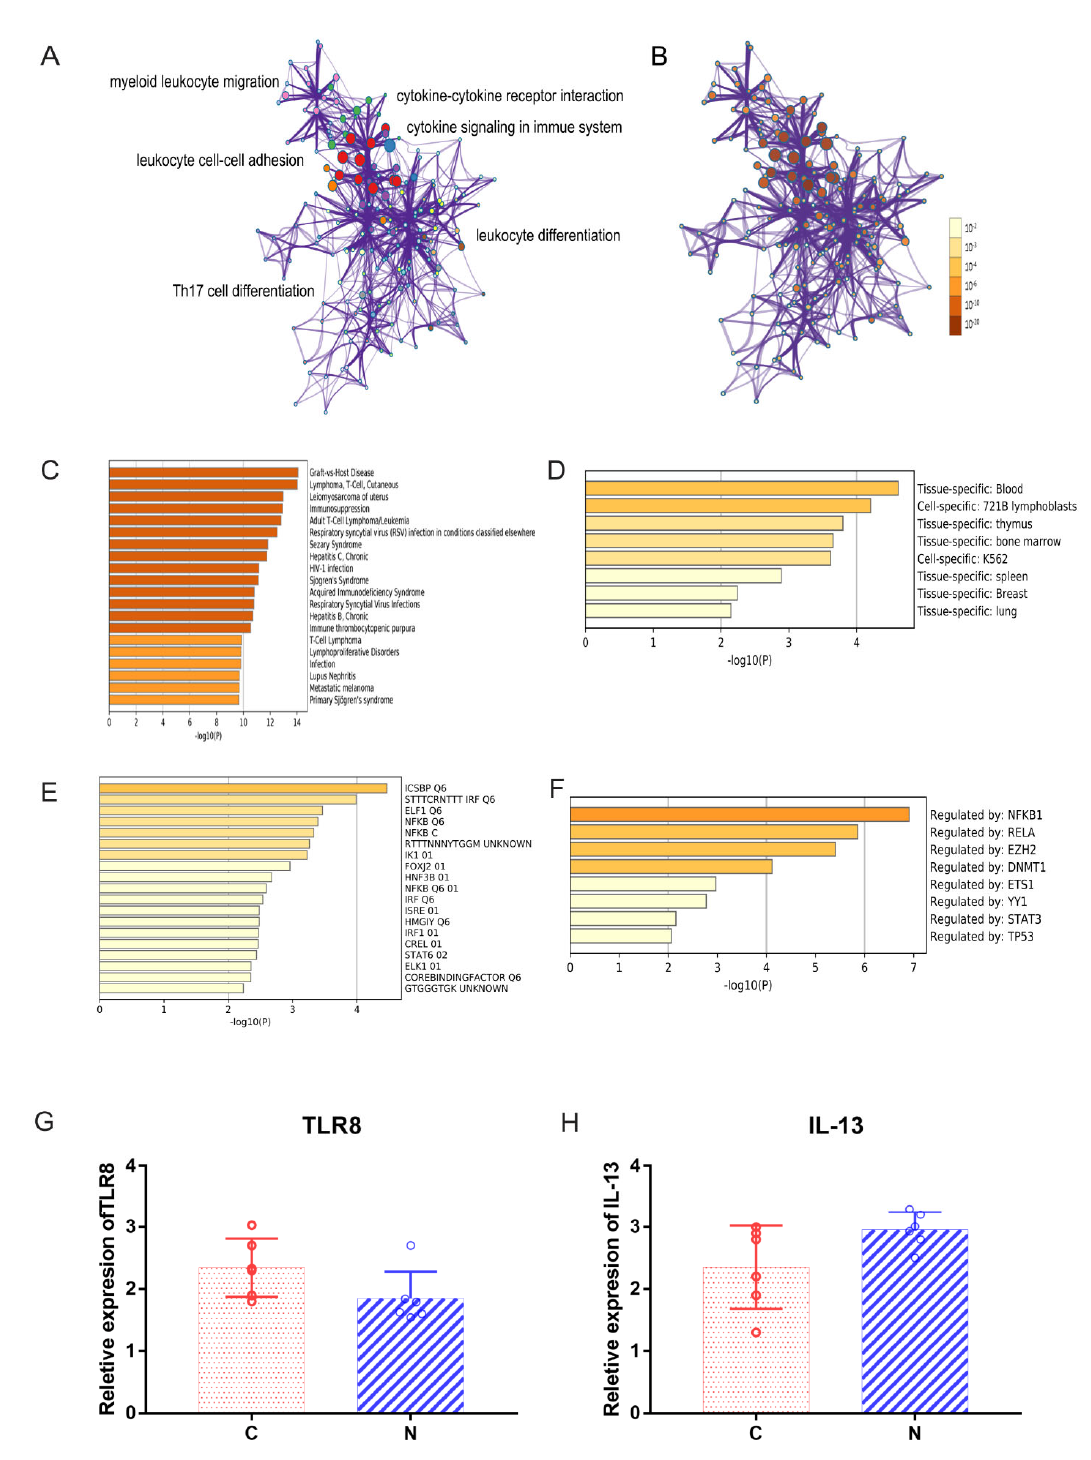
Figure 4. ( A ) Metascape analysis. We selected a subset of representative terms from this cluster and converted them into a network layout. More specifically, each term is represented by a circle node, where its size is proportional to the number of input genes falling into that term, and its color represents its cluster identity (i.e., nodes of the same color belong to the same cluster). Terms with